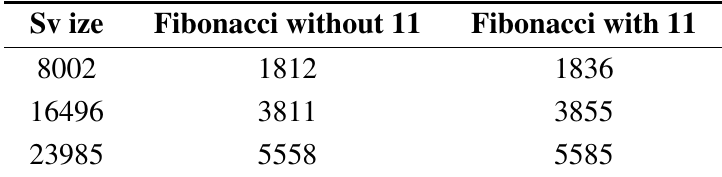
Table 3. Memory storage of the two Fibonacci